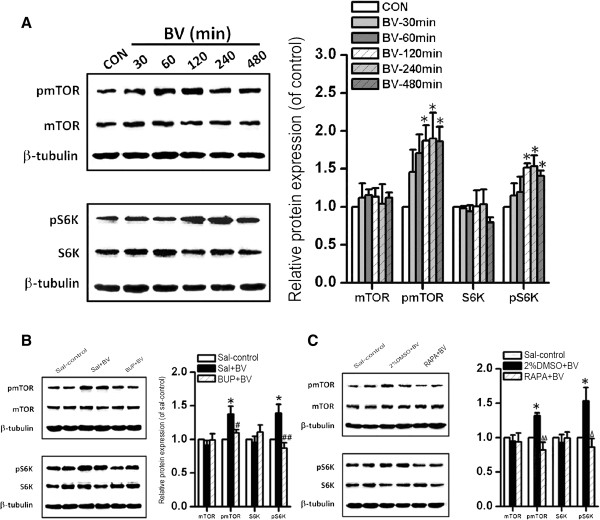
Activation of the mTOR signaling pathway in the hippocampus by persistent peripheral nociception, but the effect was reversed by rapamycin (RAPA). (A) Western blot analysis of p-mTOR, mTOR, p-S6K, and S6K expression in hippocampal lysates at various times after bee venom (BV) treatment. (B) Western analysis of p-mTOR, mTOR, p-S6K, and S6K in hippocampus tissues extracts from saline control (sal-control), Sal + BV, and bupivacaine (Bup) + BV groups. (C) Western blot analysis of p-mTOR, mTOR, p-S6K, and S6K in hippocampal lysates from Sal-control, 2%DMSO + BV, and RAPA + BV groups. Relative expresions of p-mTOR, mTOR, p-S6K, and S6K immunolabeling are shown relative to the control or sal-control (100%). β-tubulin was used as an internal control. The data were showed as means ± SD (n = 3). *P < 0.05 vs. sal-control group; #P < 0.05, ##P < 0.01, bupivacaine + BV group vs. Sal + BV; ΔP < 0.05, ΔΔP < 0.01, RAPA + BV group vs. 2%DMSO + BV group.